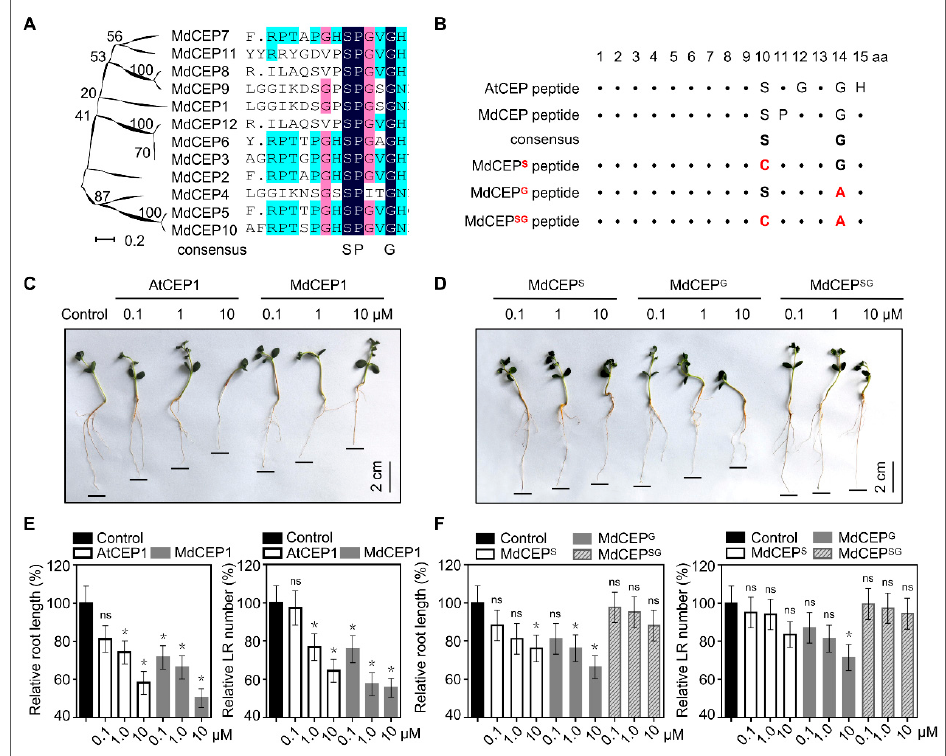
Figure 6. The conserved serine and glycine are critical for MdCEPs in root growth. ( A ) Multiple alignment of the CEP domains from 12 MdCEP members. Overall conserved amino acids are in black. ( B ) Conserved amino acids analysis of all MdCEPs and AtCEPs. Different substitution derivatives are obtained by changing the conserved amino acids indicate in red. ( C ) Inhibitory effects of exogenous AtCEP1 and MdCEP1 peptide on root growth of apple seedlings. Apple seeds were plated on MS medium with or without different CEP peptides and grown for 2 weeks. ( D ) Inhibitory effects of exogenous substitution derivatives of MdCEP1 on root growth of apple seedlings. Apple seeds were plated on MS medium with or without different CEP peptides and grown for 2 weeks. ( E , F ) The relative primary root length and lateral root number of various plants in ( C , D ). Error bars indicate SEM ( N = 3, n = 24). * p < 0.05; ns, no significance. (Student’s t